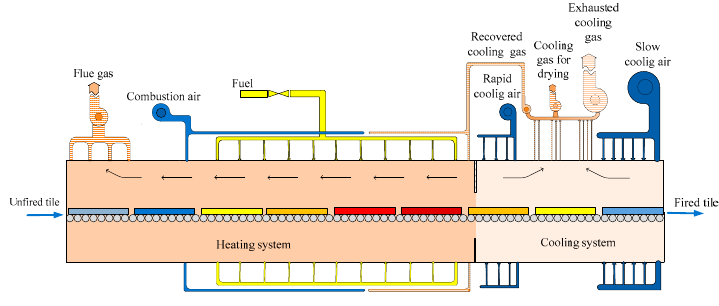
Figure 1. Schematic diagram of the roller kiln.